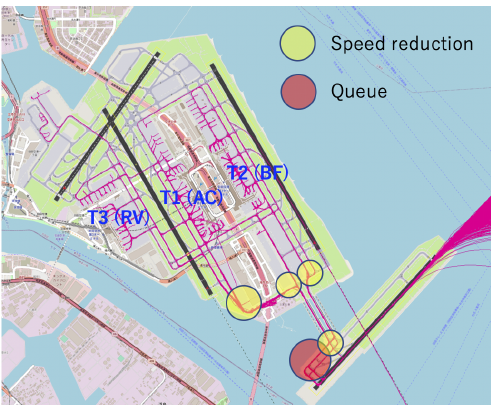
Figure 6. GS distribution of departures from T3 (R and V).